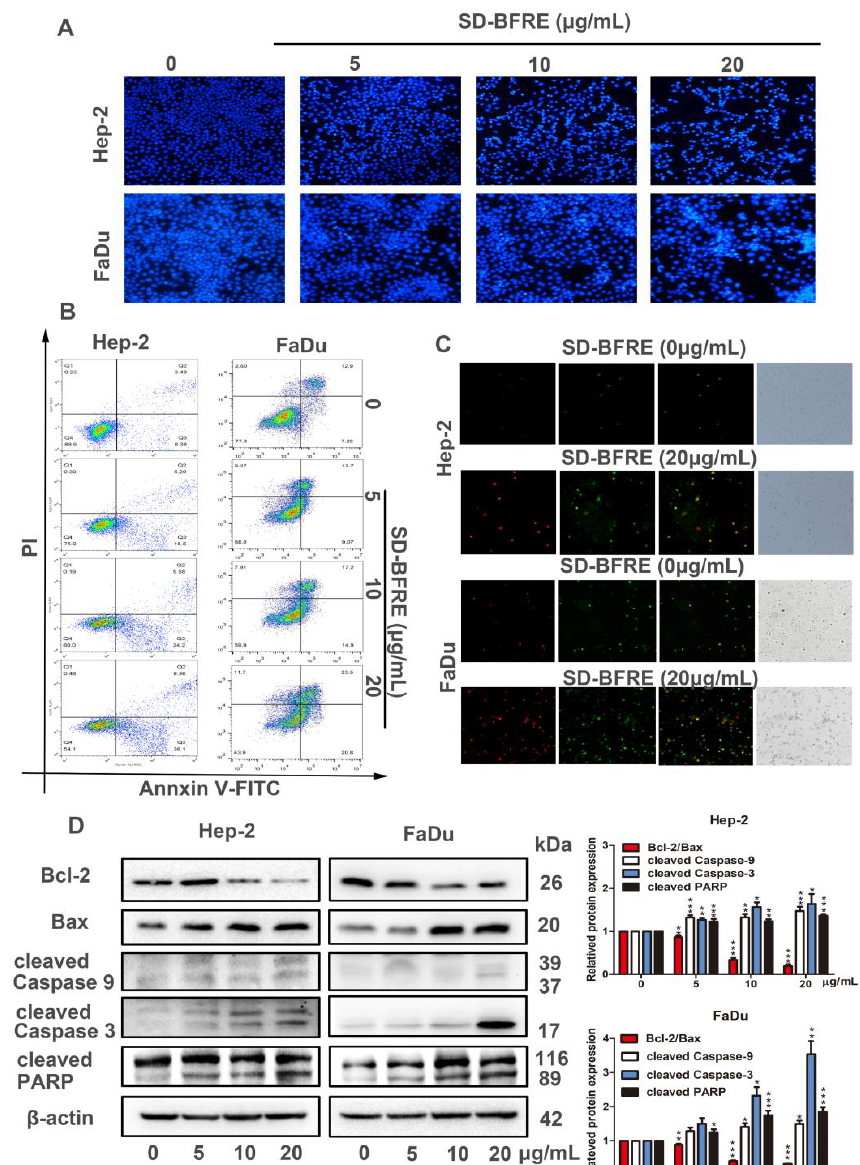
Figure 4. SD-BFRE induces apoptosis in TC cells ( A ) Two TC cells were treated with SD-BFRE for 24 h. Next, the EC cells were stained with Hoechst 33258. Its morphology was observed in a fluorescence microscope. ( B ) Cells were incubated with different concentration gradients of SD-BFRE for 24 h, then stained with Annexin V-FITC and PI. The FACS was applied to detect the proportion of apoptosis. ( C ) Hep-2 and FaDu cells were respectively treated with 0 and 20 µ g/mL SD-BFRE, then stained with Annexin V/PI staining and observed in a fluorescence microscope. ( D ) After Hep-2 and FaDu were incubated with SD-BFRE for 24 h, the expressions levels of apoptosis-related proteins were detected by Western blot assay. β -actin was served as an internal reference (* p < 0.05, ** p < 0.01 or *** p < 0.001, compare to 0 μg/mL).